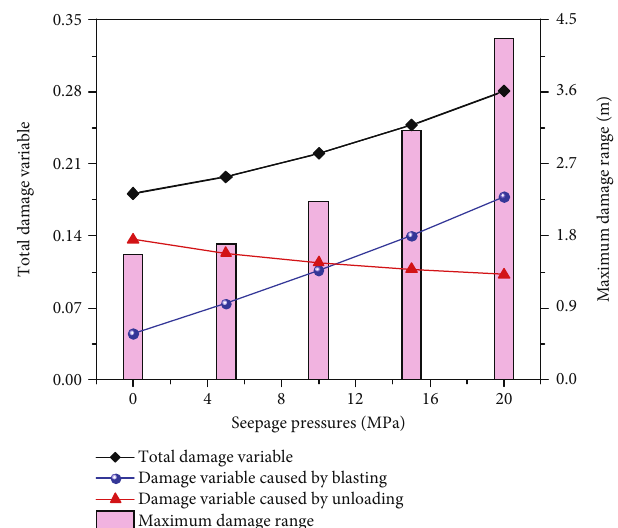
Figure 15: Damage of excavation surrounding rock under di ff erent water pressure of karst cave.